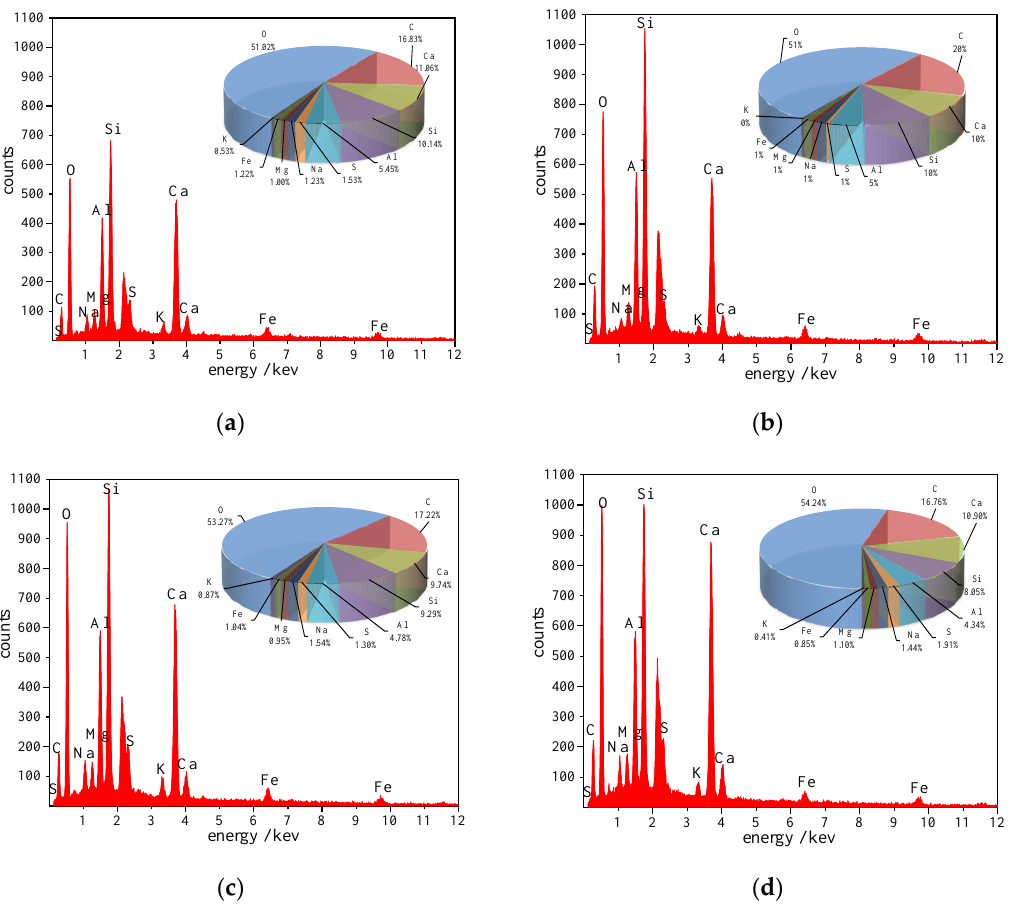
Figure 6. EDS spectrum analysis: ( a ) 10 freeze-thaw cycles, ( b ) 20 freeze-thaw cycles, ( c ) 30 freeze- thaw cycles, ( d ) 40 freeze-thaw cycles.